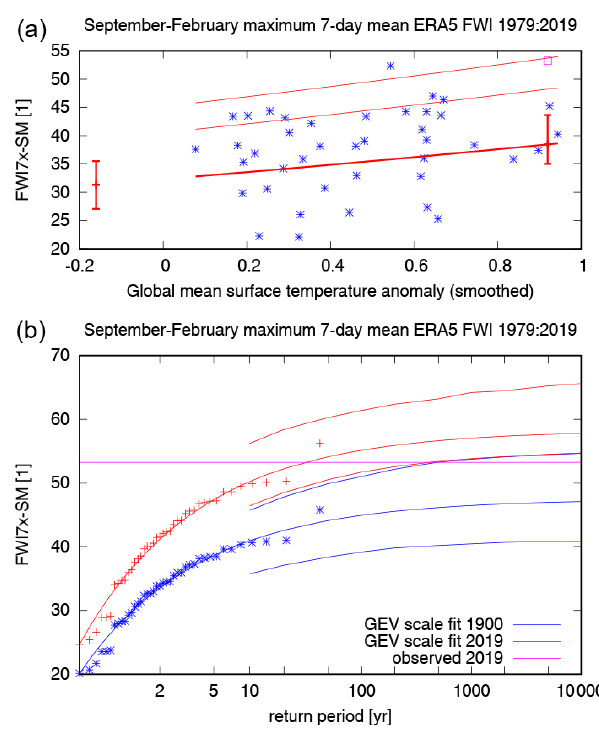
Figure 4. Fit of a GEV that scales with the smoothed GMST (Eqs. 1 and 3) of the highest 7d mean FWI computed from the ERA5 re- analysis, averaged over the index region. (a) Observations (blue symbols), location parameter µ (thick line and uncertainties in 1900 (extrapolated) and 2019/20), and the 6 and 40 year return values (thin lines). The purple square denotes the 2019/20 value, which is not included in the fit. (b) Return time plot with fits for the climates of 1900 (blue lines with 95% confidence interval) and 2019 (red lines); the purple line denotes the 2019/20 event. The observations are plotted twice, shifted down to the climate of 1900 (blue stars) and up to the climate of 2019 (red pluses) using the fitted depen- dence on smoothed global mean temperature so that they can be compared with the fits for those